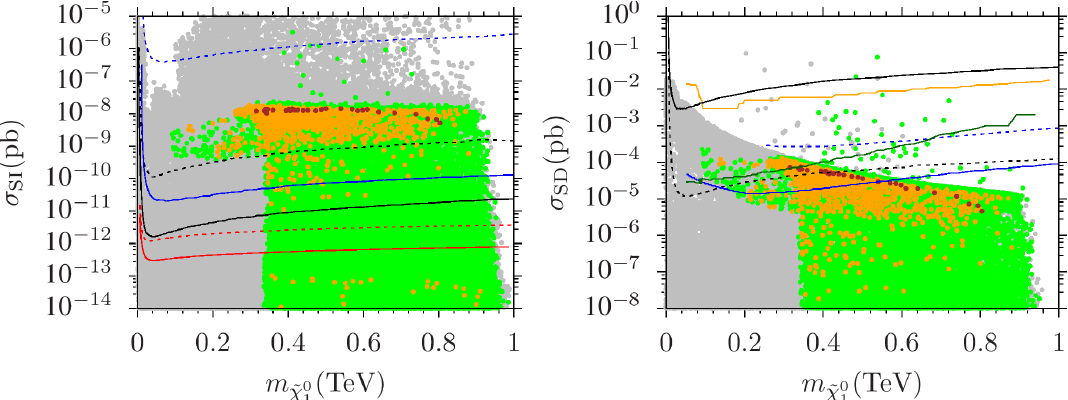
Figure 10 . Plots for the spin-independent (left) and spin-dependent (right) scattering cross-sections of the DM scattering off nuclei. The color coding is the same as figure 5. In the σ SI − m plane, the ˜ χ 0 1 blue dashed (solid) line represents the current (future) exclusion from the CDMS experiment [58, 59], while the black dashed (solid) line indicates the current (projected) results from the LUX (LZ) experiment [60]. The red dashed (solid) line displays the current (future) exclusion curve from the XENON1T (XENONnT) experiment [61]. In the σ SD − m plane, the black solid line represents ˜ χ 0 1 the current results from the LUX experiment [62], while the orange solid line indicates the current exclusion from the SuperK measurements [63]. The blue dashed (solid) line stands for the current (future) sensitivity of the IceCube experiment [64]. Finally the green solid line is provided by the CMS experiment at 8 TeV [65].